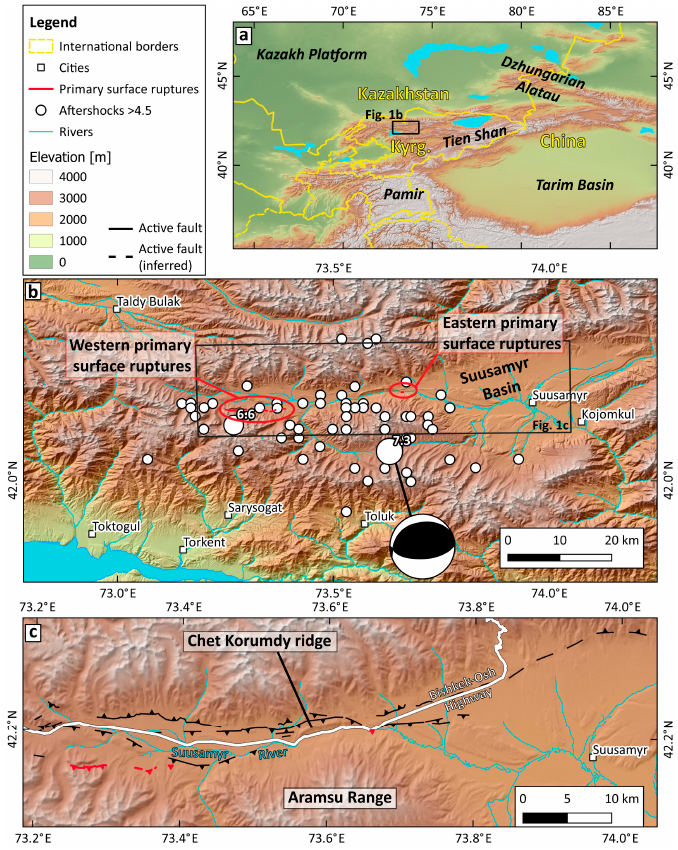
Figure 1. ( a ) The Suusamyr Basin in the Kyrgyz Tien Shan. Kyrg.: Kyrgyzstan. ( b ) Overview of the Suusamyr Basin and the 1992 earthquakes. Large white circles: M S 7.3 main shock with the Harvard CMT solution [17] and the strongest aftershock (M6.6) located with data from the Kyrgyz regional network [18]. All other aftershocks are from the compilation of Reference [19]. Elevation data: SRTM1. Note the >20 km gap in between the two sets of primary surface ruptures. ( c ) The Suusamyr fault system (from Reference [7]) and location of the Bishkek-Osh Highway.